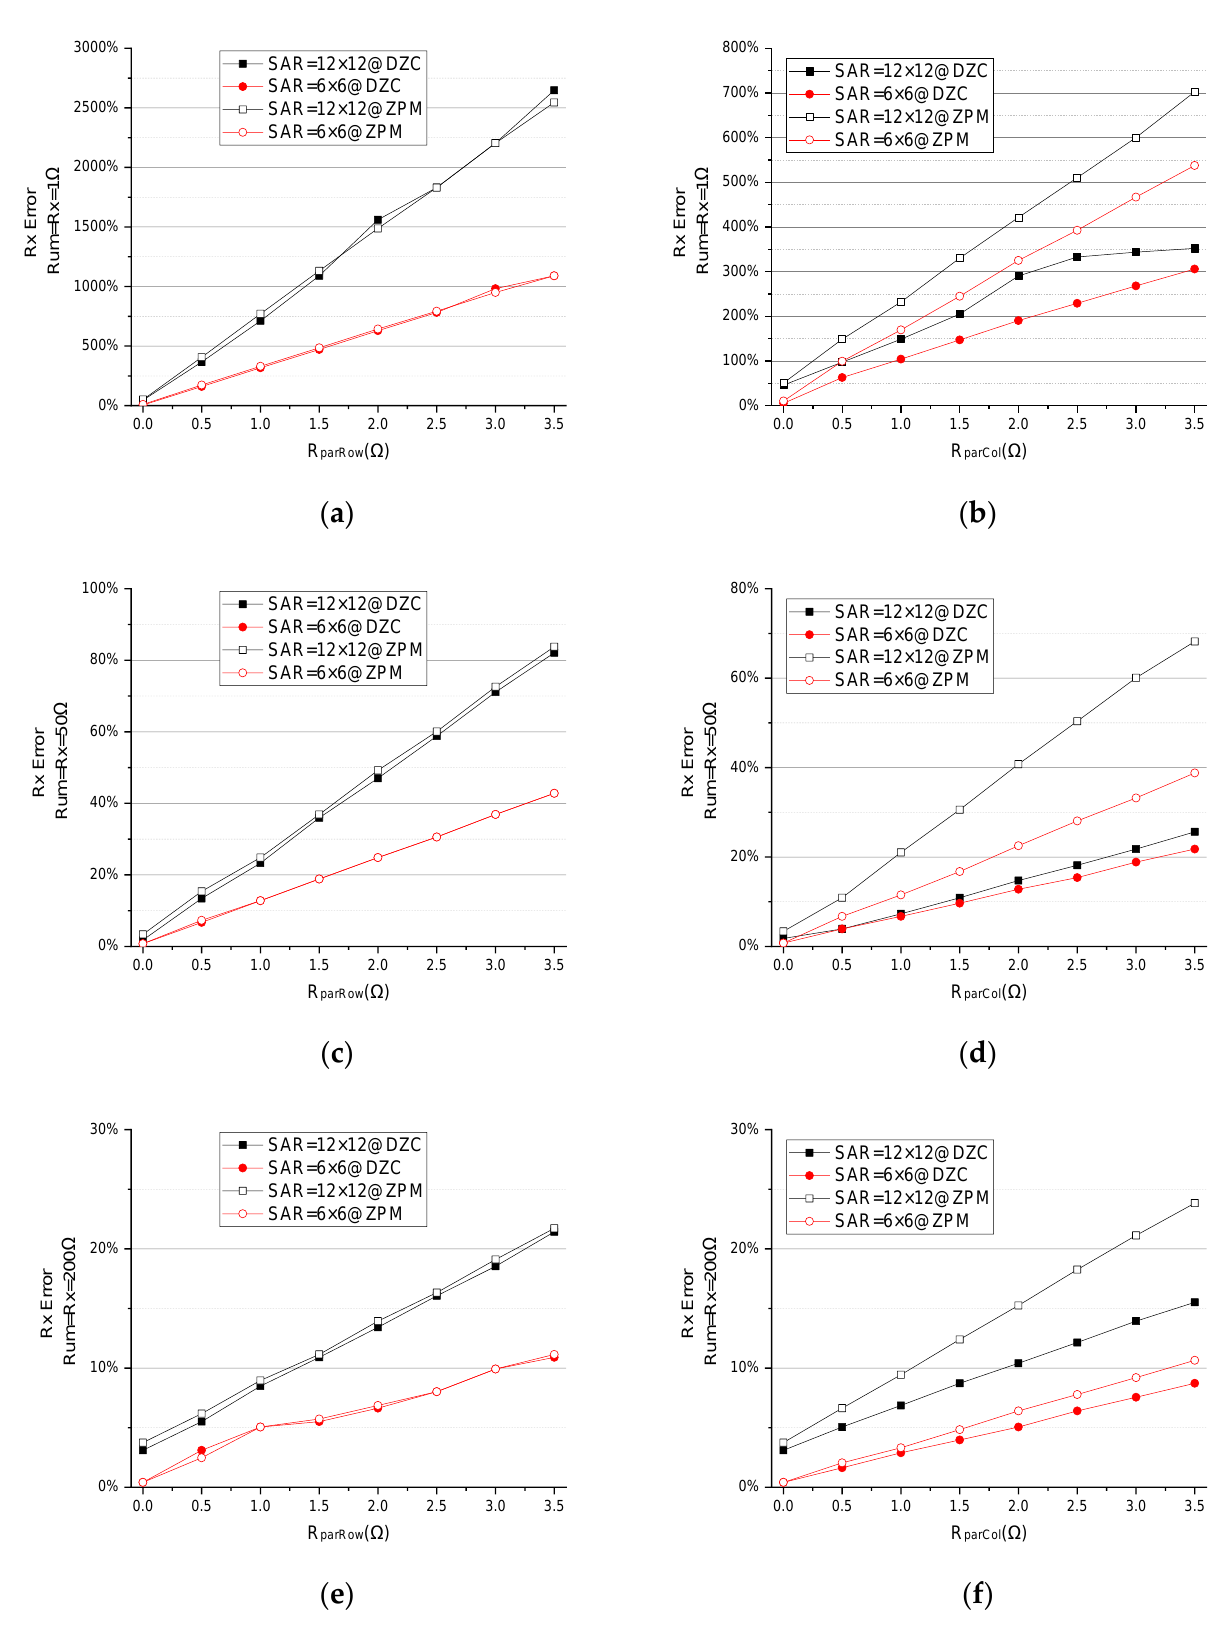
Figure 10. The effect of 𝑅 𝑝𝑎𝑟 on measurement error of different 𝑆 𝐴𝑅 = 6 × 6, 12 × 12 when 𝑅 𝑥 = Figure 10. The effect of R par on measurement error of different S AR = 6 × 6, 12 × 12 when 𝑅 = 1 Ω, 50 Ω, 200 Ω . ( a , c , e ) Effect of 𝑅 R x = R um = 1 Ω , 50 Ω , 200 Ω . ( a , c , e ) Effect of R parRow and ( b , d , f ) effect of R parCol in DZCM 𝑢𝑚 and ZPM (EXP (EXP C).